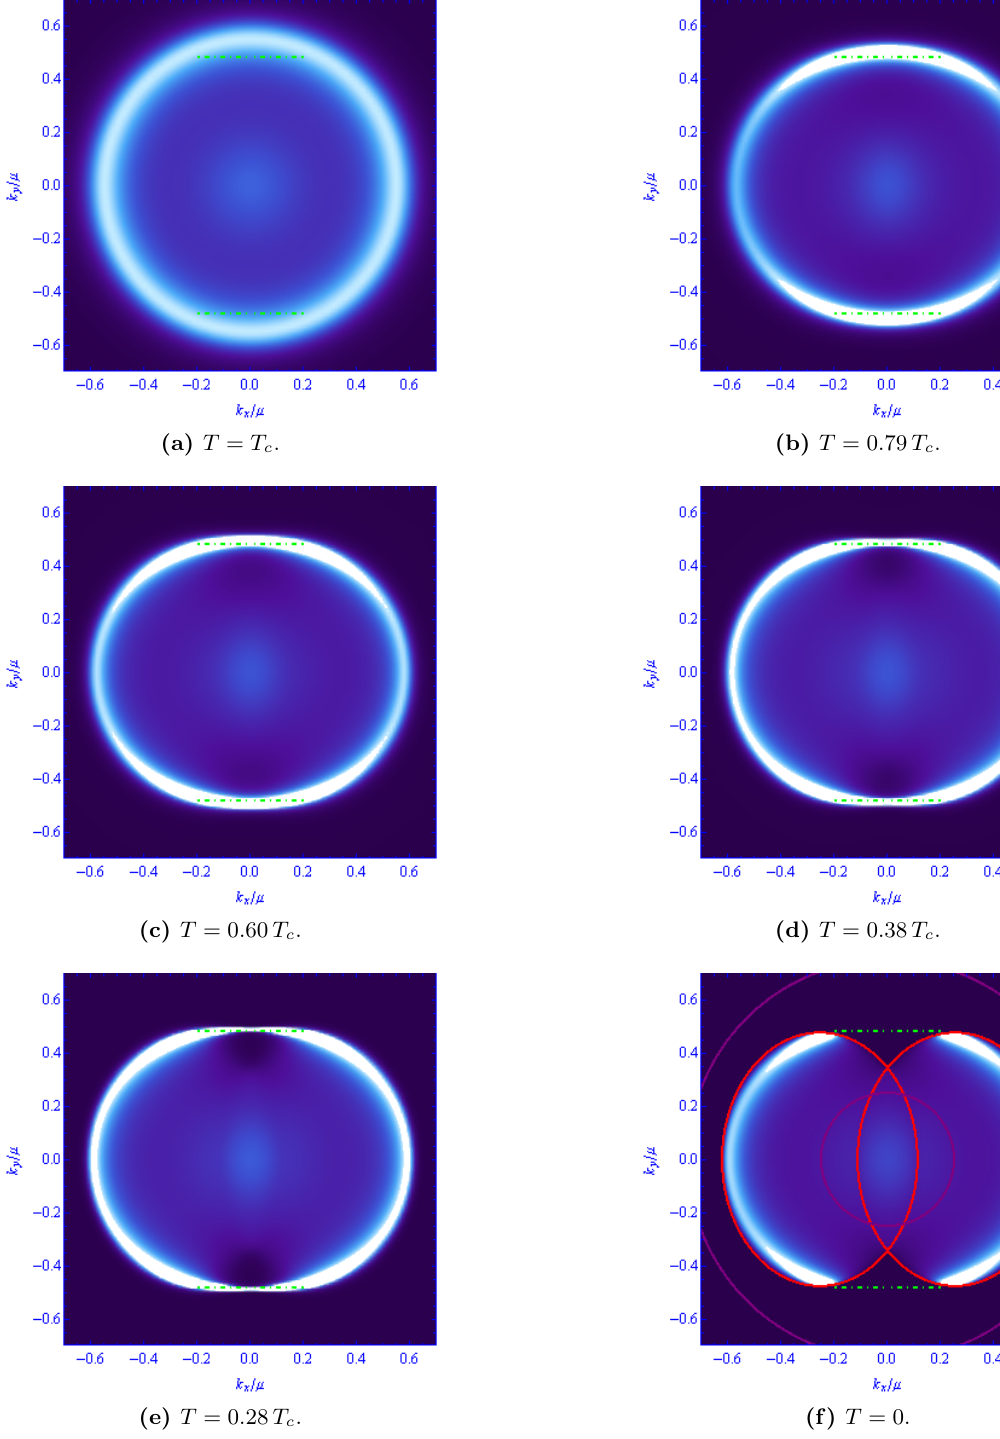
Figure 8. The spectral function for di(cid:11)erent temperatures and (cid:12)xed (cid:21) = 0 : 62 = (cid:21) c , ! = 0 : 25 (cid:22) . It is observed the presence of spherical symmetry at T = T c . The dashed lines indicates the locus of the normal modes. The purple and red circles represent the UV and IR Dirac cones respectively.